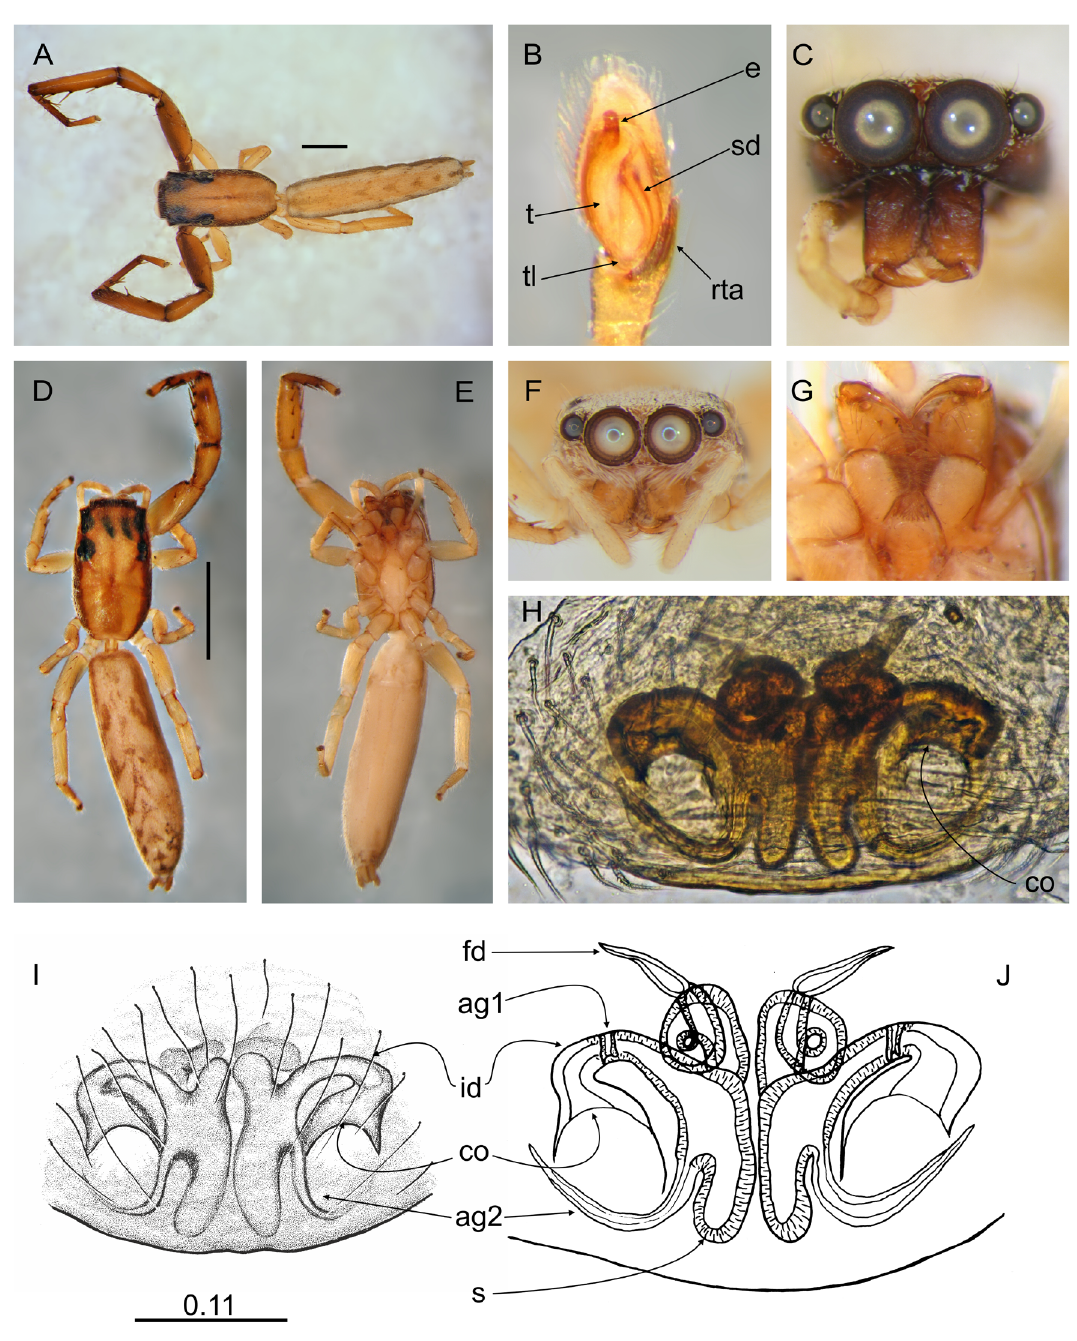
Fig. 3. Corambis foeldvarii Szűts, 2002. A–C. Mt Dzumac (USMB). D–J. Paratype (HNHM 2014a). A, C . Dorsal and frontal views, ♂. B . Palpal organ, ♂. D–F . Dorsal, ventral and frontal views, ♀. G . Chelicerae, maxillae and labium, ♀. H, J . Internal genitalia, ♀. I . Epigyne, ♀. Scale bars: A, D = 1